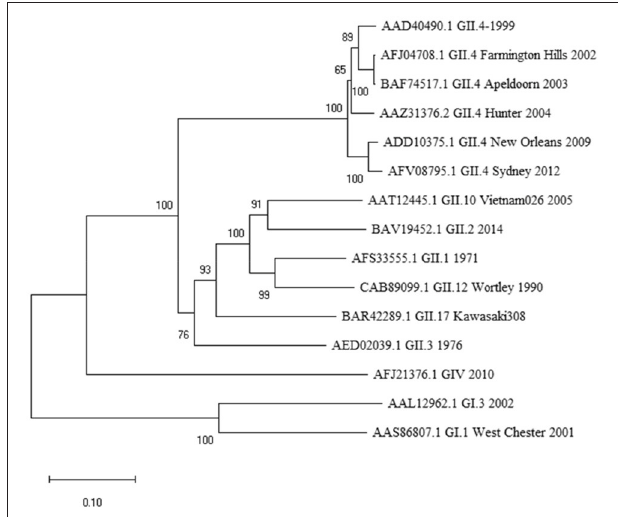
FIGURE 1 | Phylogenetic analysis of norovirus major capsid protein VP1 amino acid sequences. The tree was inferred by Neighbor-Joining method with a bootstrap of 500 by using MegaX. The scale bar shows the genetic distance, expressed as amino acid substitutions per site.